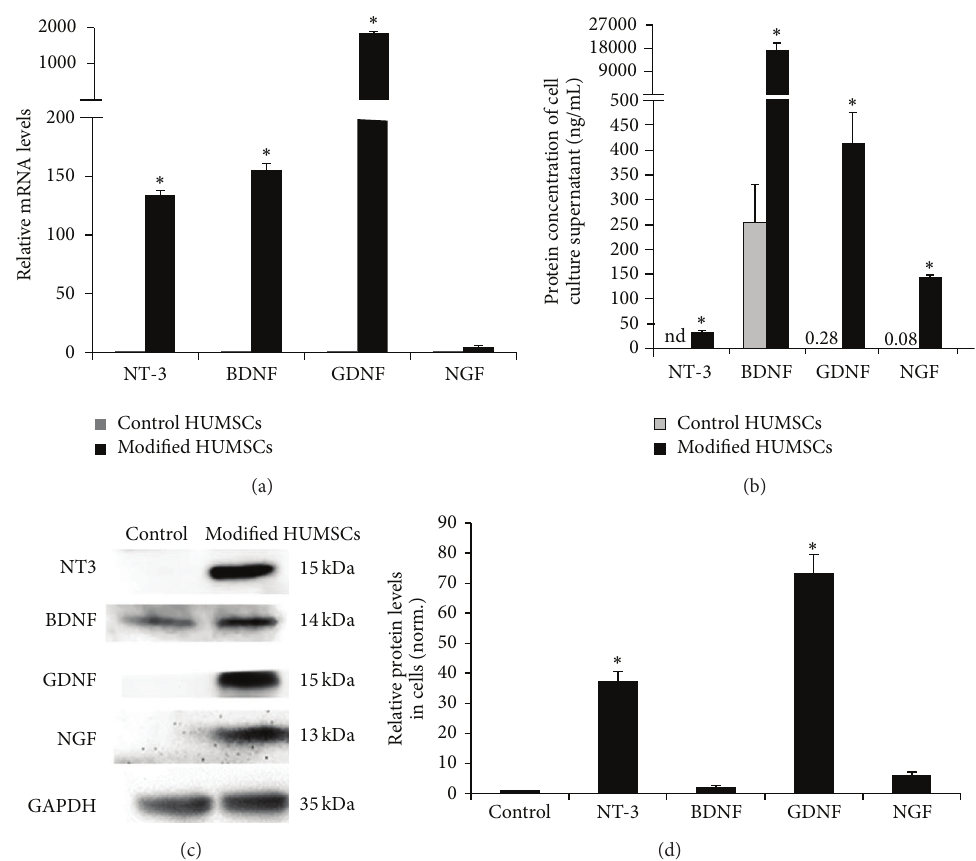
Figure 2: HUMSCs were transduced with control lentiviral vectors or those designed to overexpress NTFs. Overexpression of NTFs was then confirmed at both mRNA and protein levels. (a) mRNA was extracted from HUMSCs 3 days after transduction and measured by real-time reverse transcription polymerase chain reaction ( 𝑛 = 3 ). (b) Protein levels of NTF were measured in supernatant of HUMSCs using enzyme- linked immunosorbent assay ( 𝑛 = 3 ). (c) Protein levels of NTF measured in HUMSCs using western blot. (d) Semiquantitative analysis of results of western blot. ∗ 𝑃 < 0.05 versus control ( 𝑛 = 3